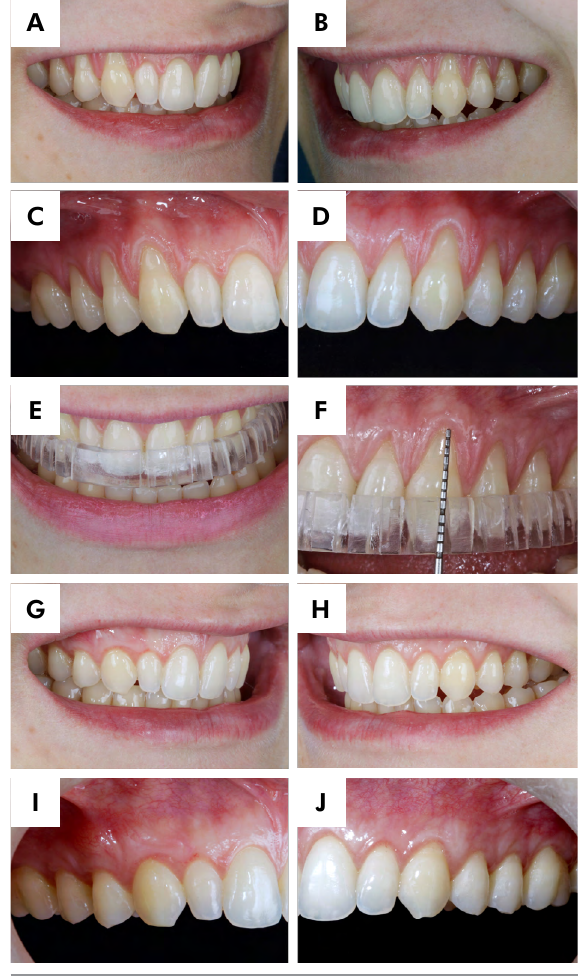
Figure 1. A. Initial appearance of the smile on the right side; B. Left side; C and D. Gingival recessions before surgical procedures; E and F. The measurements were performed using a North Carolina probe (PCPUNC 15 ® Hu Friedy, Chicago, USA) and a standardized stent. Twelve months post-operative; G. Final aspect of the smile on the right side; H. Left side; I. Root coverage with CTG treatment; J. Root coverage with CM